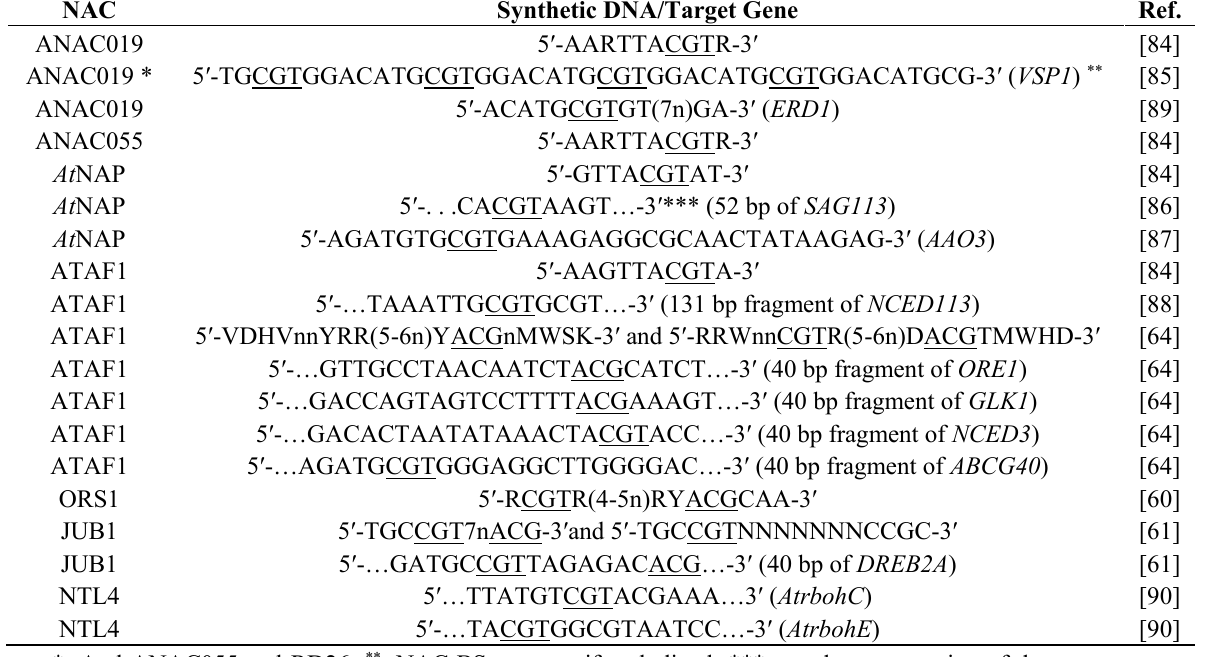
Figure 2. Structure and interactions of NAC protein domains. ( a ) Model of dimeric ANAC019 NAC domain (shown in green) bound to target DNA (PDB accession code 3SWP) [82]; ( b ) Interactions of senescence associated ANAC046 and RCD1. ANAC046 has a folded N terminal DNA binding NAC domain (here shown as an ellipse and in ( a ) as a cartoon) and an intrinsically disordered C-terminal transcription regulatory domain (shown as different conformers). ANAC046 uses its C-terminal molecular recognition feature (shown as a small ellipse in the different conformers) for interactions with RCD1, likely in competition with other yet unidentified proteins (shown by “?”). The interactions are indicated by arrows. RCD1 in turn is a hub protein and interacts with multiple transcription factors (shown by arrows), including ANAC046 and DREB2A, by exploiting the flexibility of their intrinsic disorder as shown by different conformers. The transcription factors may compete for the same binding site in RCD1 as shown by the common origin of the arrows on RCD1. The figure is based on work by Jaspers et al. [91] and O’Shea et al. [92]. Table 1. DNA and promoter sequences bound by senescence associated NAC proteins. NAC Synthetic DNA/Target Gene